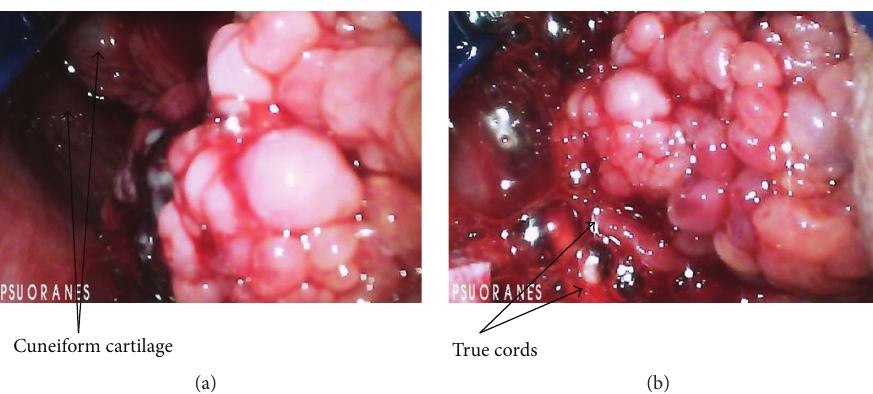
Figure 1: The large fungating mass coming from the base of the tongue obstructs the view of the epiglottis and vocal cords. The epiglottis is out of picture but would be close to the left upper corner of the picture, with the base of the tongue oriented towards the right border of the picture (a). After deeper insertion of the glidescope, the mass is seen hanging in the pharynx close to the true vocal cords, which are pulled to the right